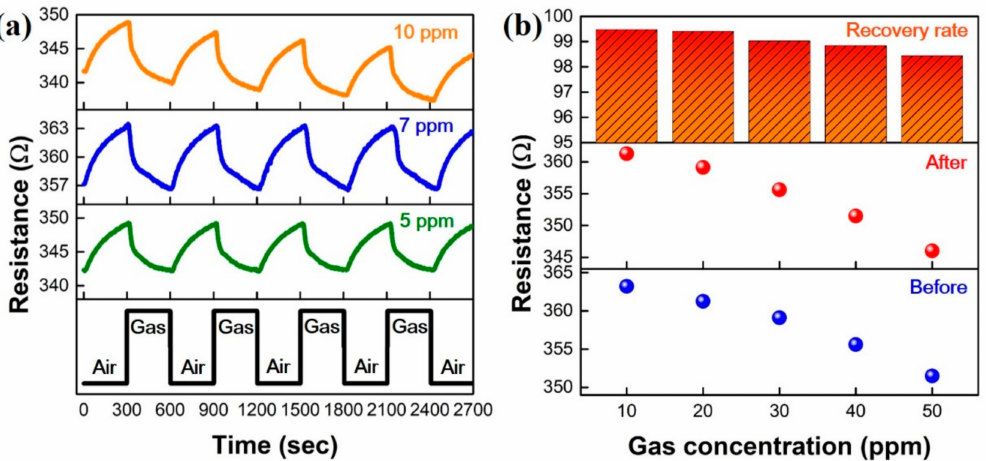
Figure 6. Repeatability and recovery characteristic in NO 2 gas-sensing performance of GNWs/NiO- WO 3 /GNWs heterostructure-based gas sensor. ( a ) Repeatability at low NO 2 concentration. ( b ) Re- covery characteristic on range of NO 2 concentration from 10 to 50 ppm.